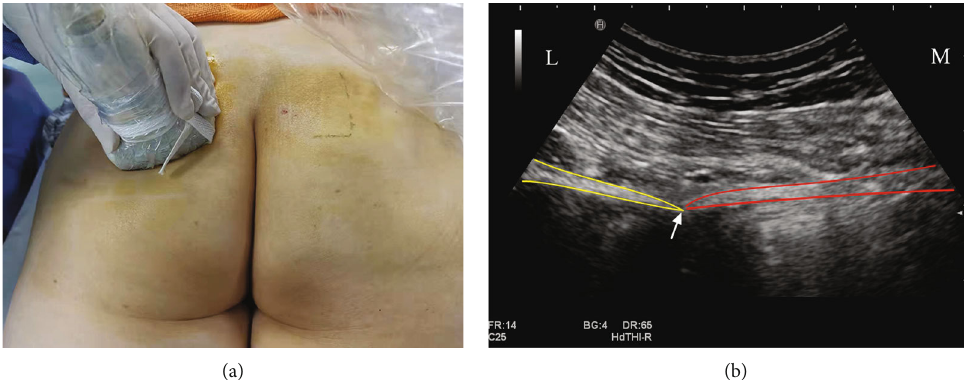
Figure 1: Diagnostic block of the pudendal nerve under ultrasound guidance. (a) Position and direction of the ultrasonic probe. (b) Transverse section of the ultrasound image in the ischial spine. Red outline: sacrospinous ligament; yellow outline: ischium; white arrow: ischial spine. L: lateral; M: medial.